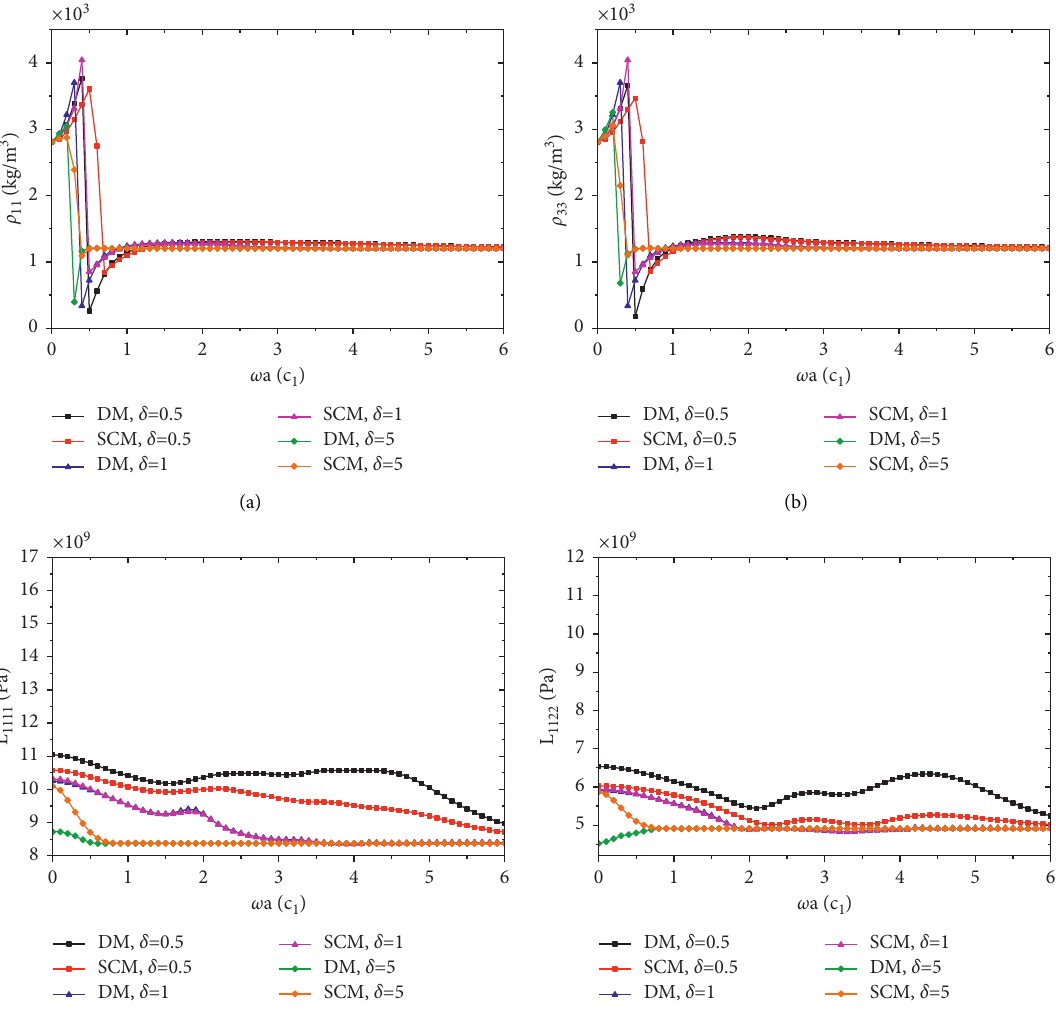
, L , L , and L are obtained by the differential method (DM) and 1111 1122 1133 3333